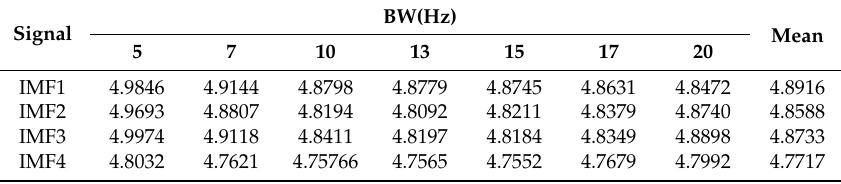
Table 3. The calculated spectral kurtosis entropies.